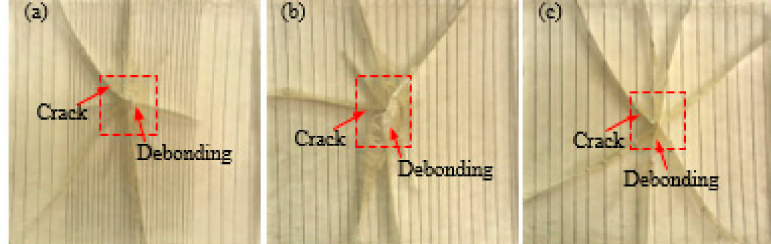
Figure 9. The failure modes diagrams of specimens with different SMA layup spacing values and diameters under 5 J of energy: ( a – c ) indicate the SMA reinforced resin-matrix test specimens with SMA diameters of 0.3, 0.4, 0.5 mm, respectively, and SMA layup spacing of 2, 3.7, 6 mm,